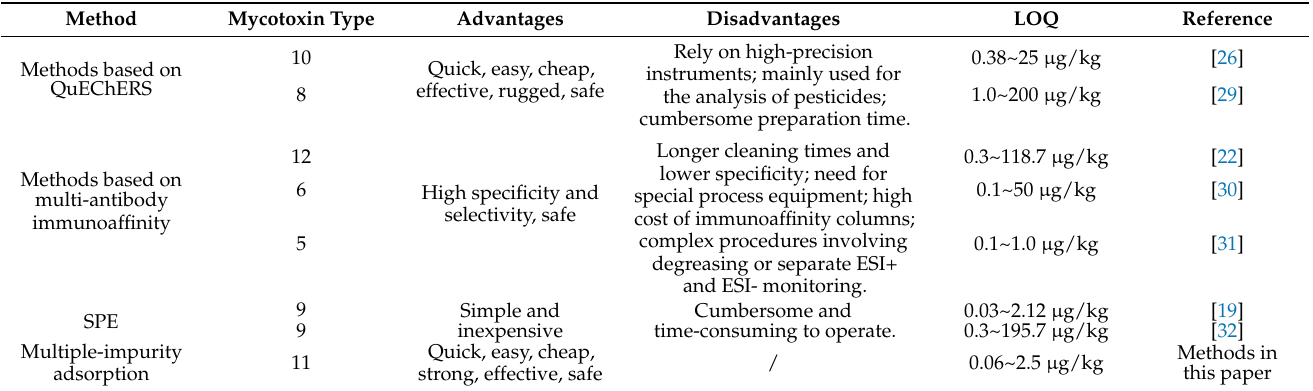
Table 6. Comparison of methodological properties of different detection